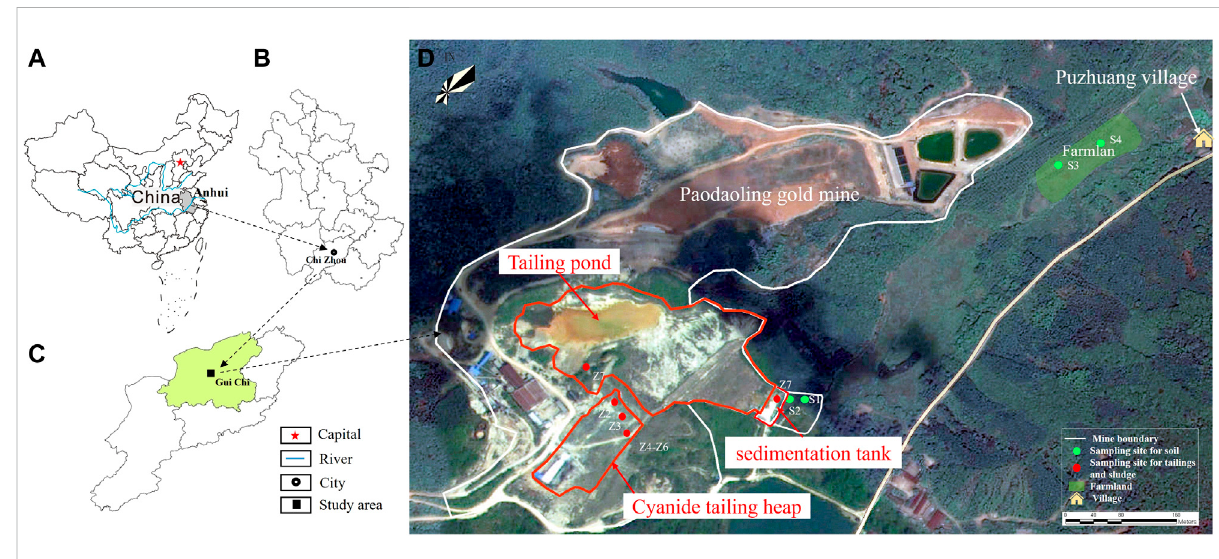
FIGURE 1 Mining boundary and surrounding land use type. Location of study area and the distribution of